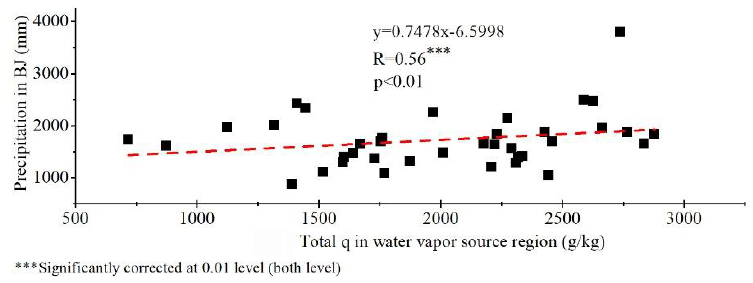
Figure 8. ( a ) Changes on average δ 18 O and precipitation during the snow season in ER (Erlangen), CL (Cluj), CA (Cahul), KR (Kursk), KH (Kharkhiv), AS (Astrakhan) and Urumqi. ( b ) The spatial distribution of ER, CL, CA, KR, KH, AS and Urumqi. ( c ) The elevation, distance to Urumqi and observation span information of ER, CL, CA, KR, KH, AS and Urumqi.